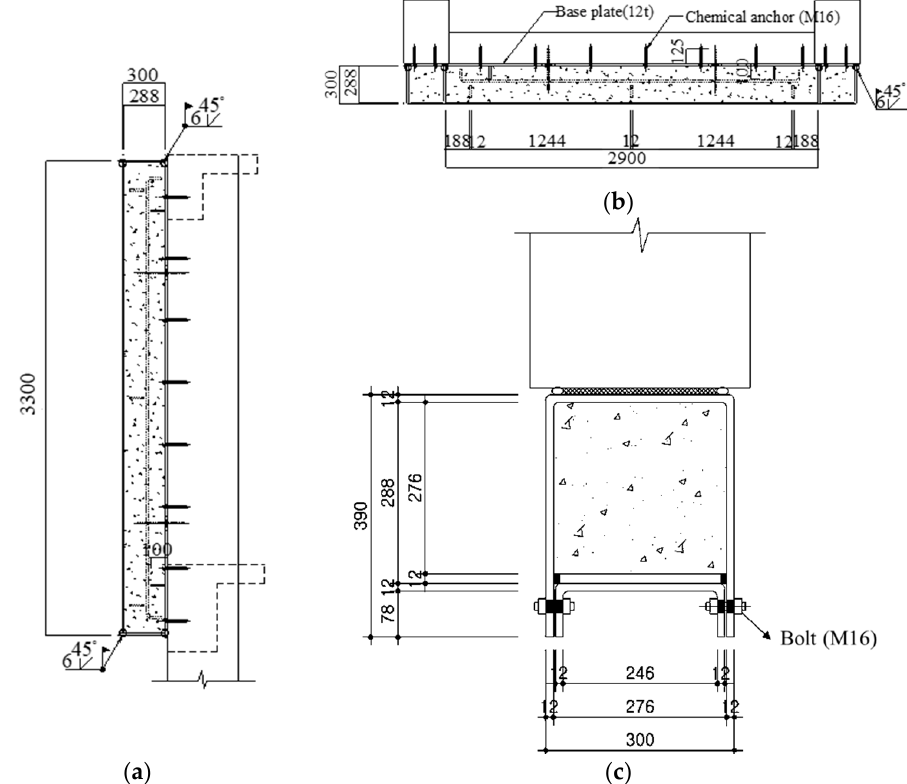
Figure 5. Drawing of CFST attached to the NoWS specimen (mm). ( a ) Vertical cross-section; ( b ) horizontal cross-section; ( c ) connection with bolting.